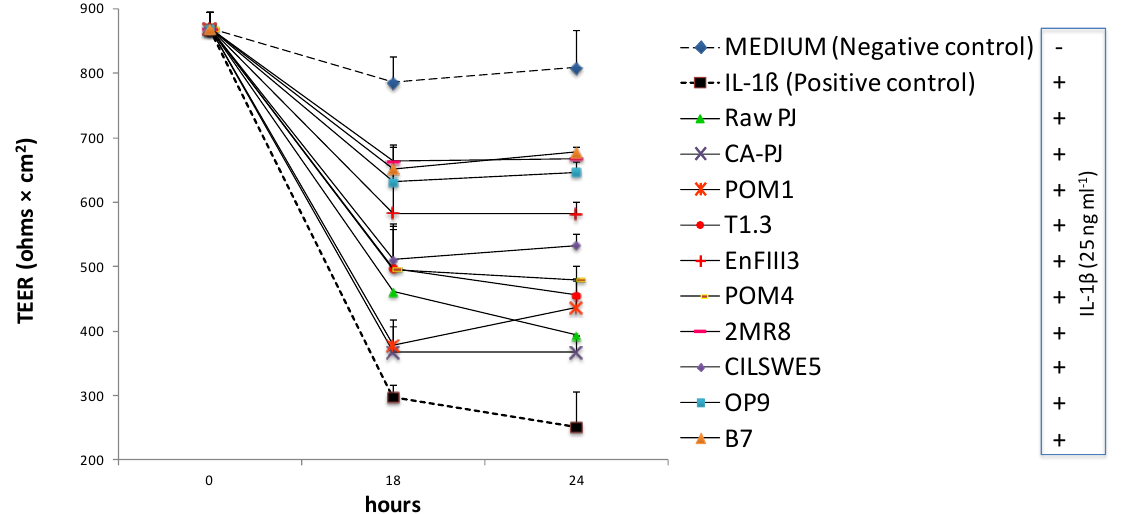
Figure 5. Transepithelial electric resistance (TEER) (Ohms × cm 2 ) of Caco-2 cells. Caco-2 cells were pretreated for 6 h with raw Portulaca oleracea L. juice (Raw-PJ), chemically acidified PJ (CA-PJ), and PJs fermented (30 ◦ C for 36 h) by Lactobacillus plantarum POM1, T1.3, and EnFIII3, Lactobacillus brevis POM4, Lactobacillus rossiae 2MR8, Pediococcus pentosaceus CILSWE5, Leuconostoc mesenteroides OP9, and Lactobacillus kunkeei B7, and incubated 24 h with interleukin 1 β (IL-1 β ) (25 ng/mL). Data are the means ( ± SD) of three biological replicates analyzed in triplicate.